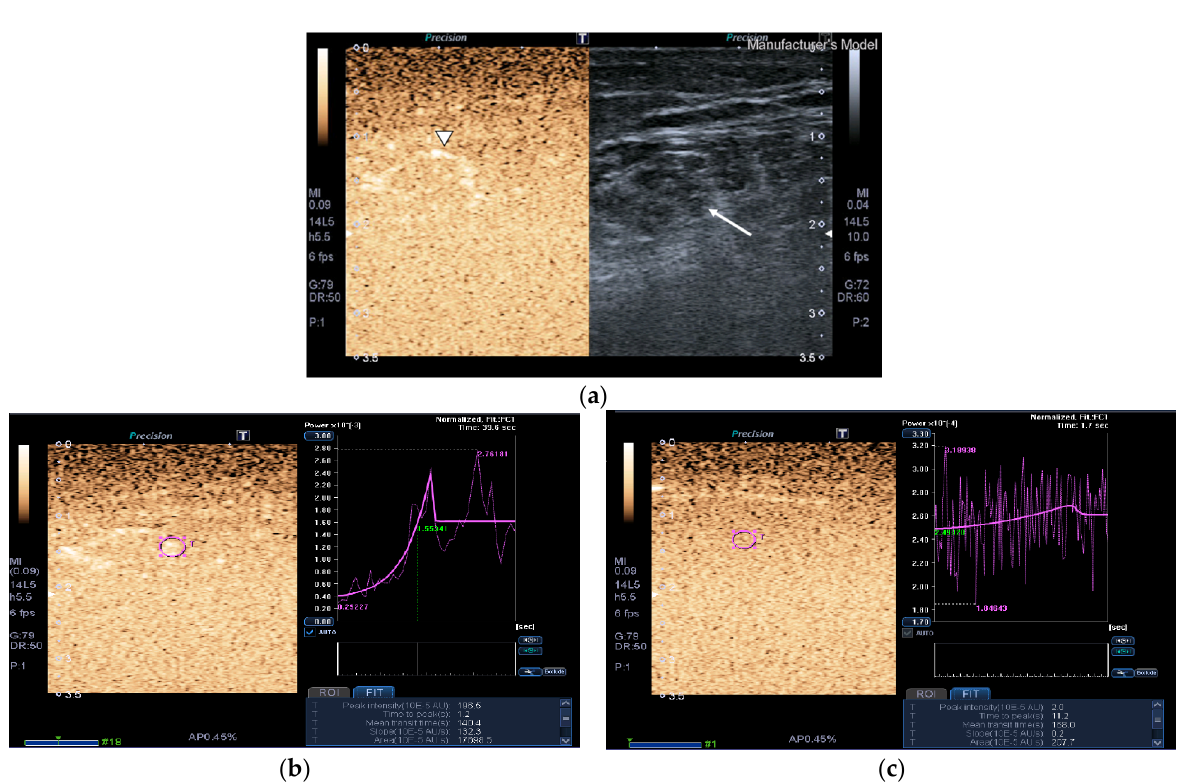
Figure 3. Transversal QRF muscle of a matched healthy control (85 years old). ( a ) Transversal ultrasonography scan shows the QRF muscle (arrow) and vascularization after contrast-enhanced ultrasound (CEUS) administration (arrowhead). CEUS image and time–intensity curve analysis are shown using the built-in software. ( b ) ROI (pink circle) in the area of strongest enhancement indicates maximum perfusion in the QRF. ( c ) ROI (pink circle) in the area of lowest enhancement indicates minimum perfusion in the QRF.